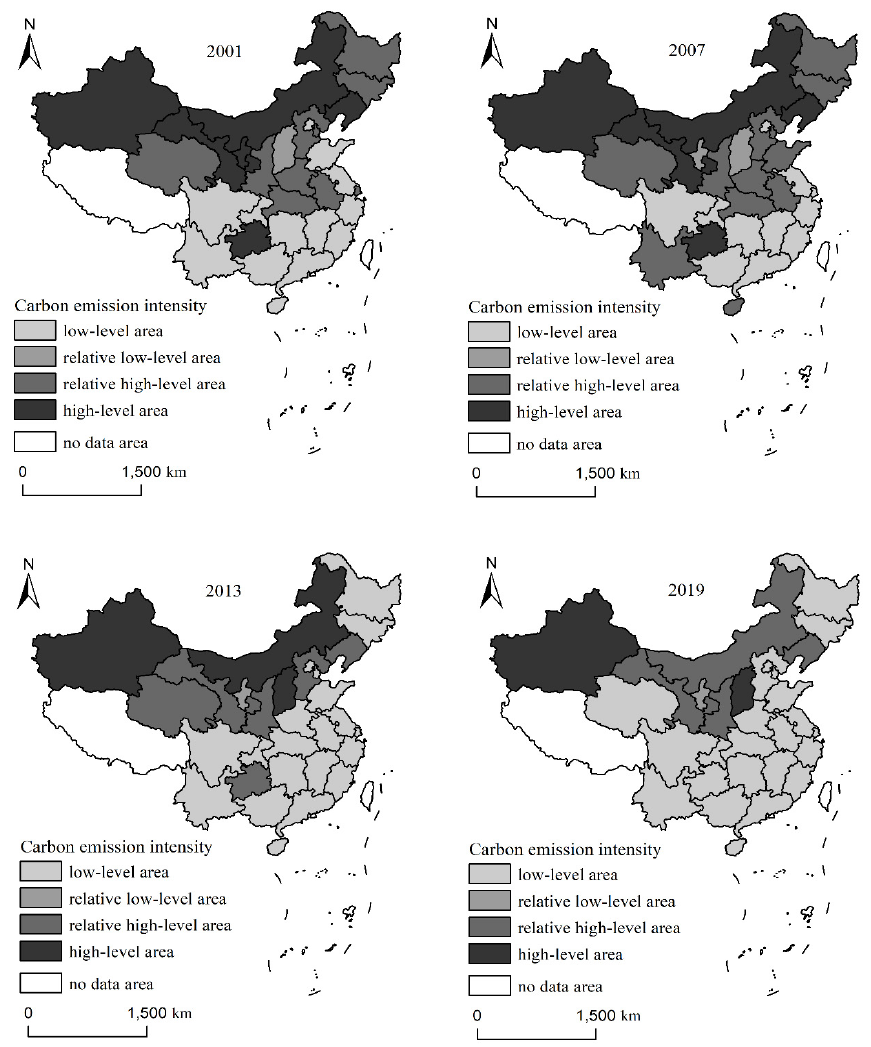
Figure 3. The spatial distribution pattern of carbon emission intensity in China